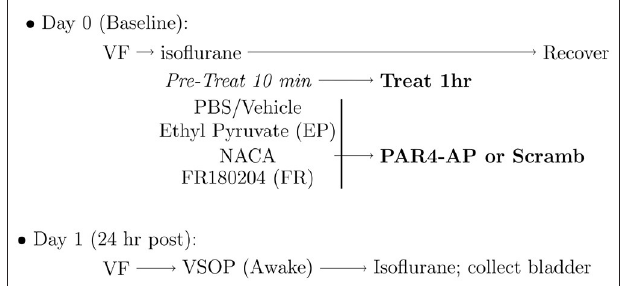
FIGURE 1 | Experimental protocol for induction of bladder hyperalgesia (BHA). Baseline 50% von Frey (VF) threshold was measured before administering intravesical pre-treatments to block protease activated receptor-4 (PAR4)-induced BHA as detailed in the Methods section. NACA, N-acetylcysteine amide; PAR4-AP, PAR4-Activating peptide; VSOP, voided stain on paper.